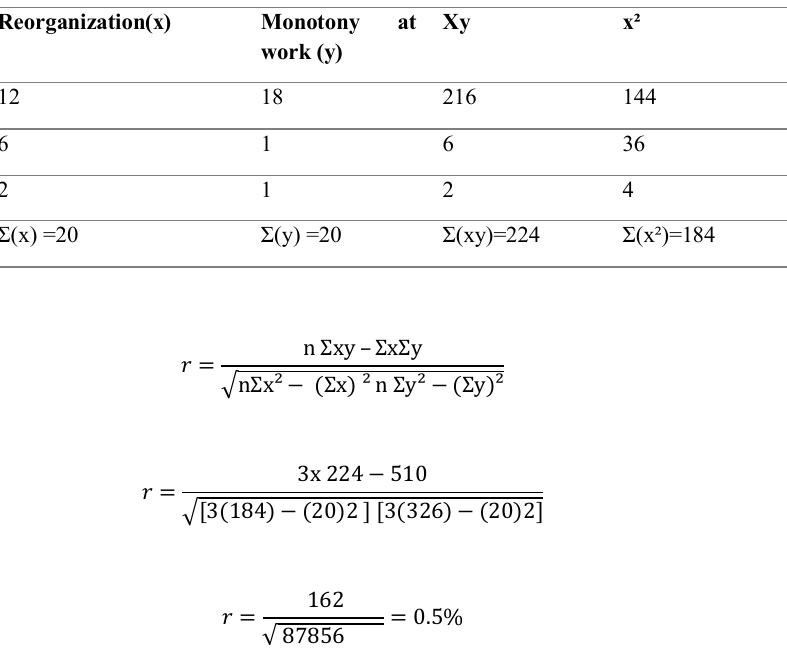
Table 5: An analysis of the relationship between the process of reorganization and the elimination of monotony at